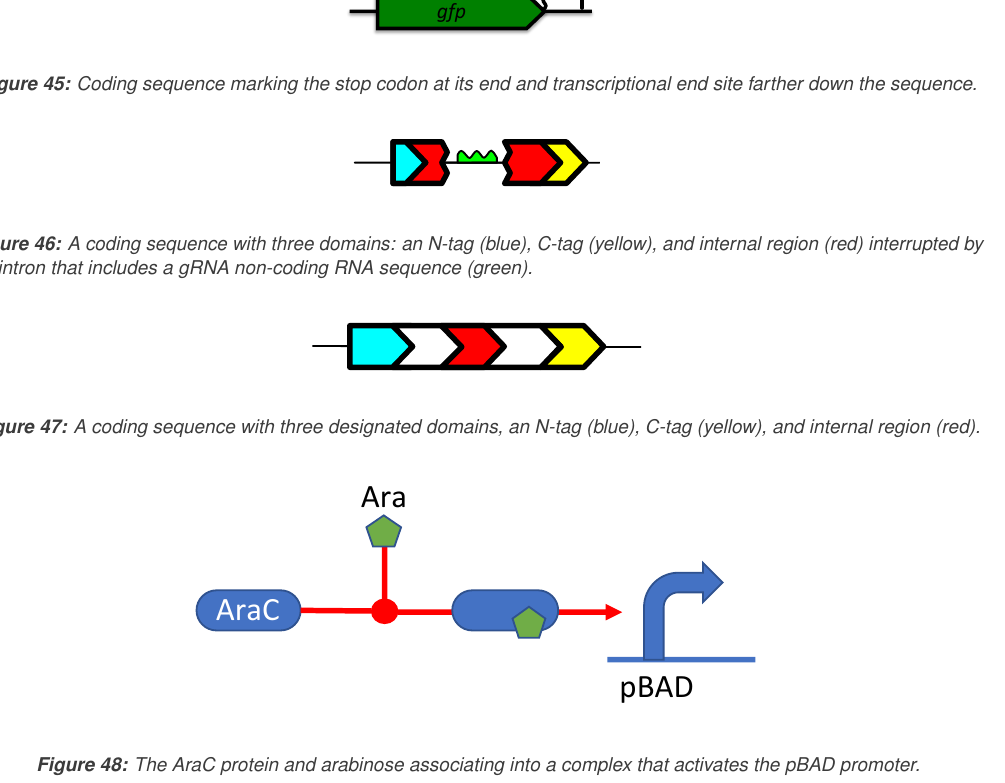
Figure 48: The AraC protein and arabinose associating into a complex that activates the pBAD